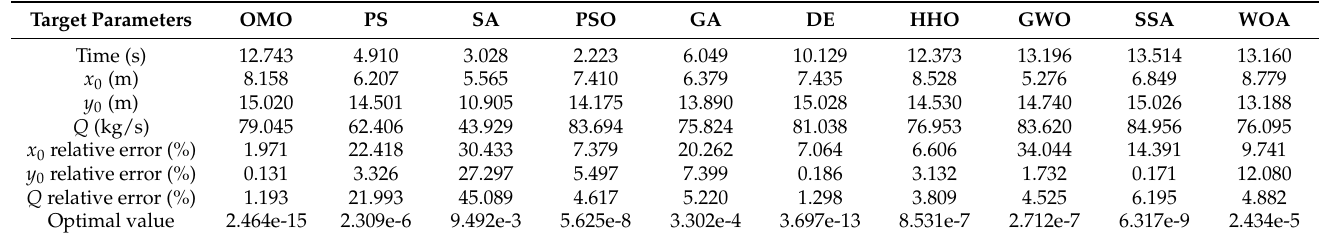
Table 16. Comparison of results of different optimization algorithms under 16 sensors.